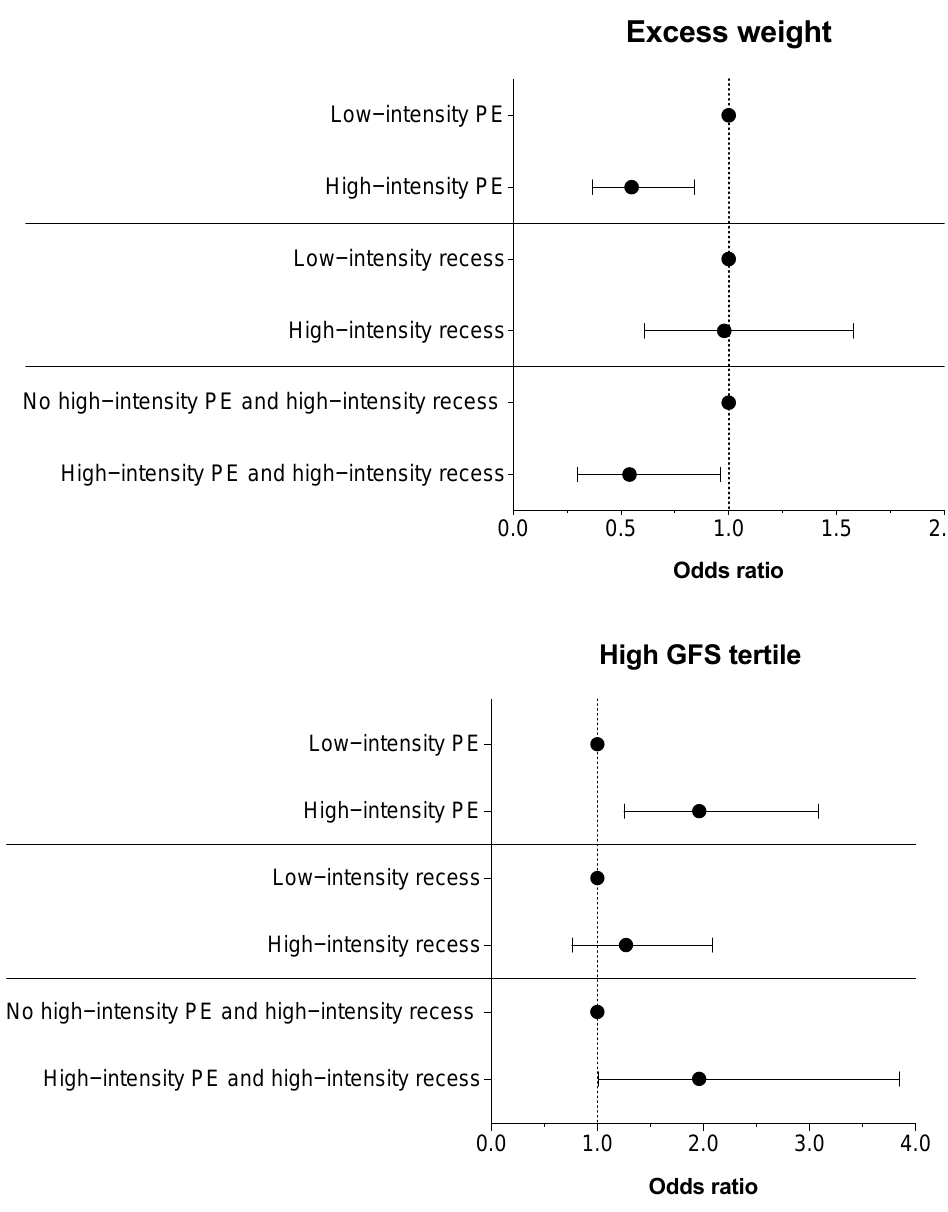
Figure 3. Association between physical activity intensity during Physical Education classes and school recesses and excess weight and global physical fitness according. Analyses were adjusted by sex, age, type of schooling, area of residence, immigrant status, daily screen time, and weekly sport activities. BMI, body mass index; GFS, Global Fitness Score; PE, physical education.